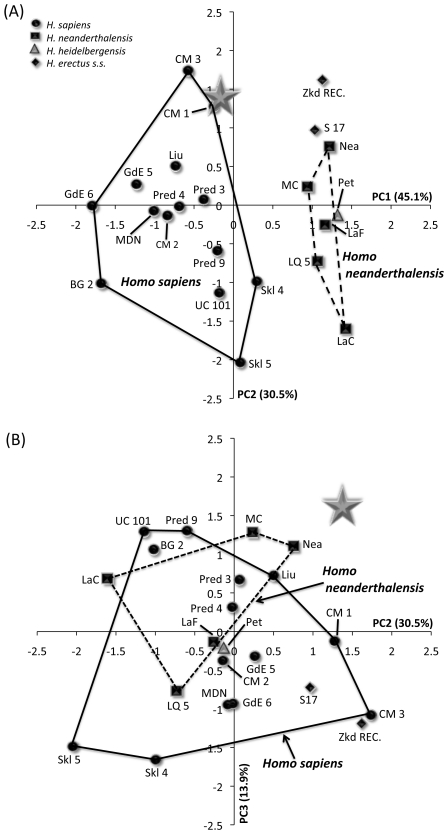
Object plots from principal components analysis including MLDG 1704 and 23 later Pleistocene fossil crania.(A) PC 1 versus 2, and (B) PC 2 versus PC 3 (NB: Gray star = MLDG 1704; BG = Barma Grande; CM = Cro Magnon; GdE = Grotte de Enfants; LaC = La Chapelle; LaF = La Ferrassie; Liu = Liujiang; LQ = La Quina 5; MC = Monte Circeo; MDN = Mai Da Nuoc; Nea = Neandertal; Pet = Petralona; Pred = Predmost; S = Sangiran; Skh = Skhul; UC = Upper Cave-Zhoukoudian; and Zkd = Zhoukoudian ERECT).